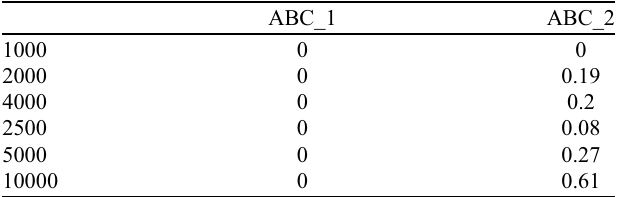
Table 4. Comparison of different variants of ABC algorithm for Example 1 (welded beam) with different function evaluations for the success rate obtained in 100 runs.